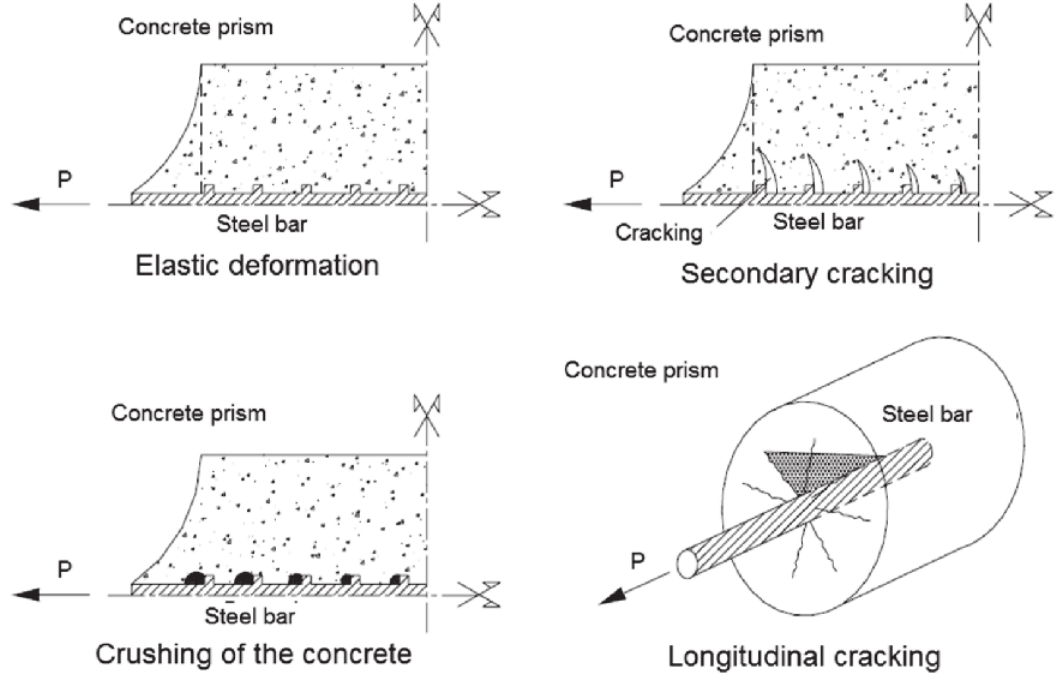
Figure 3 Failure modes of steel-concrete adherence | From: Almeida Filho [16] p.